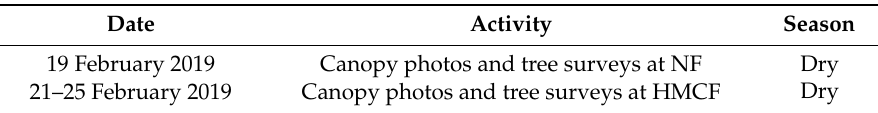
Table 1. Summary of in-situ fieldwork.